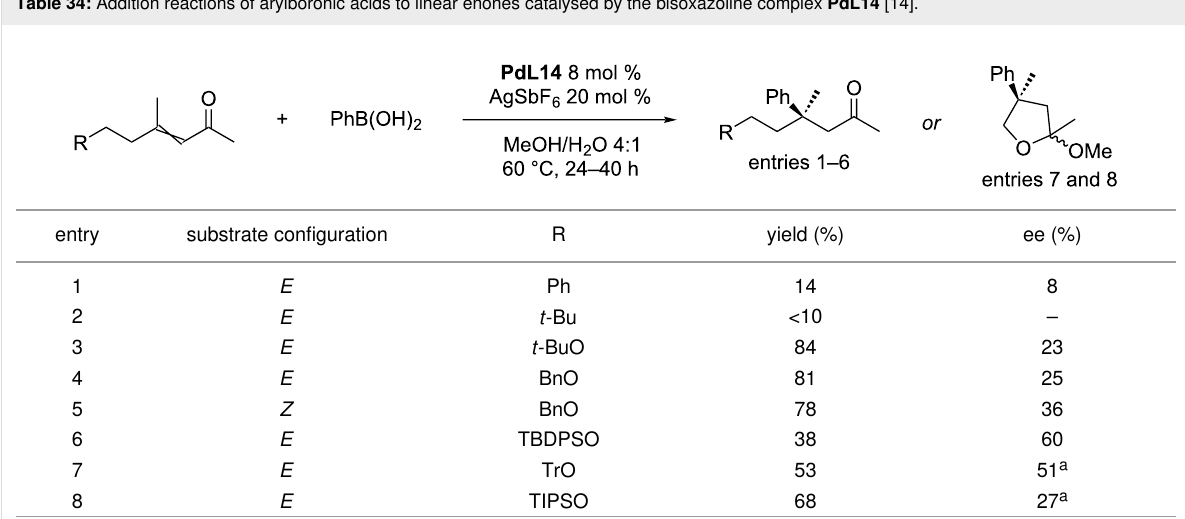
Table 34: Addition reactions of arylboronic acids to linear enones catalysed by the bisoxazoline complex PdL14